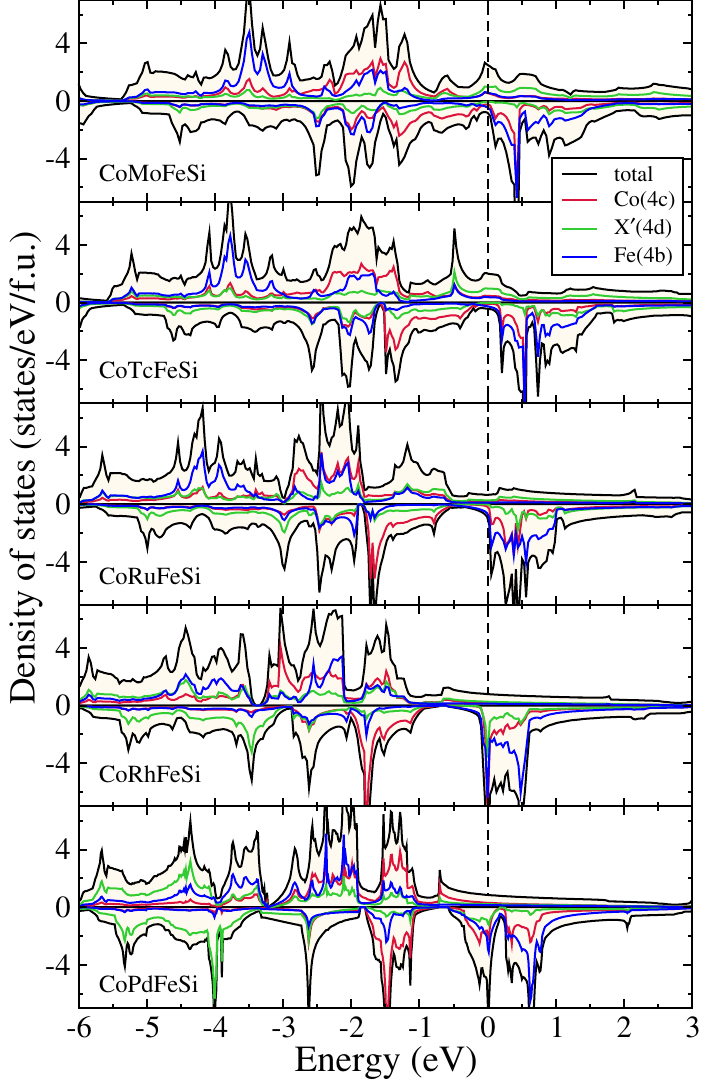
Figure 7. Spin polarized total and atom-projected densities of states for CoX ′ FeSi (X ′ = Mo, Tc, Ru, Rh, Pd) compounds. The ground states of these compounds are